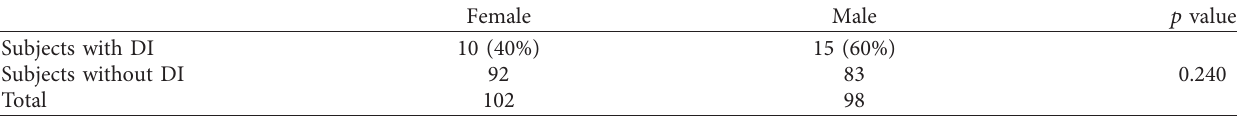
Table 1: Distribution of subjects with dens invaginatus.